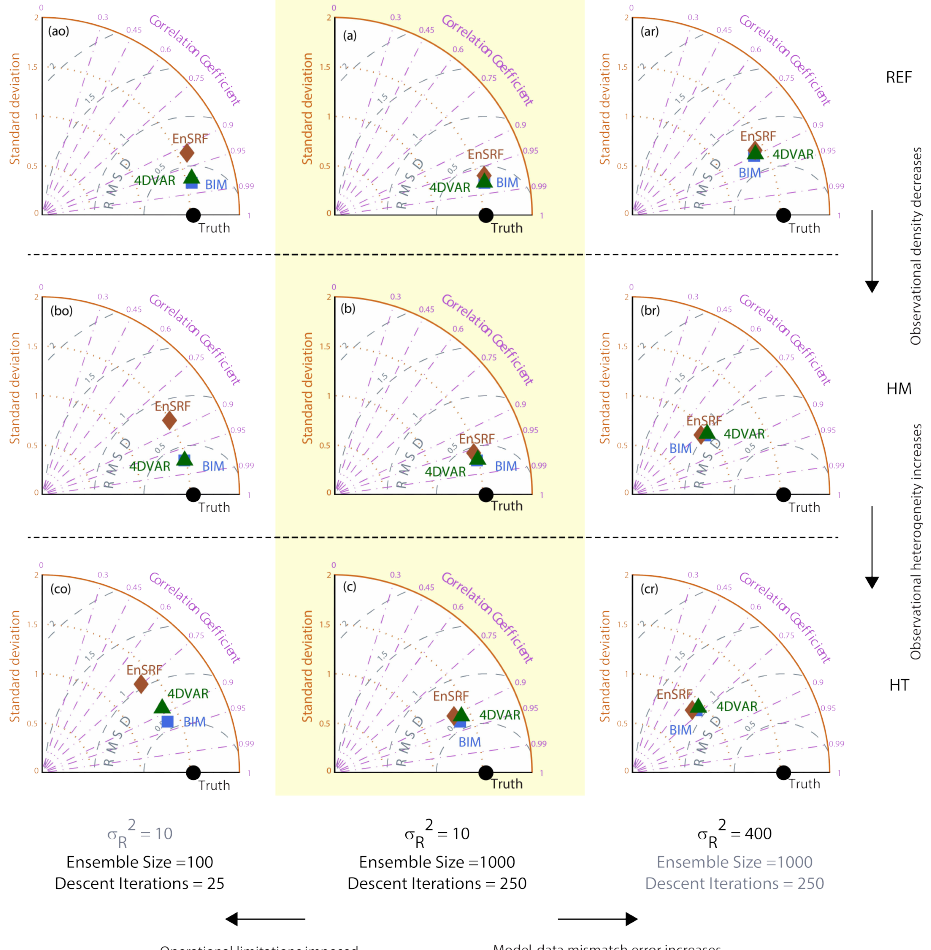
Fig. 4. Performance of the BIM, the EnSRF, and the 4D-VAR approaches for the different experiments outlined in Table 1. For each experi- ment, statistics are calculated between the estimates and the true fluxes across all locations and all 30 time periods and are represented on a Taylor diagram. For each Taylor diagram, the true flux is represented by a point along the abscissa corresponding to the standard deviation of the true fluxes (“Truth”). All other points (“BIM”, “EnSRF”, “4D-VAR”), which represent the estimated fluxes, are positioned such that their standard deviation is the radial distance from the origin, the correlation coefficient between the estimates and the truth is the cosine of the azimuthal angle, and the root-mean-square difference (RMSD) between the estimates and the truth is the distance to the observed point. In the limit of perfect agreement, these other points would coincide with “Truth” (i.e., RMSD=0, CC=1, and SD of the estimates would be the same as that of the